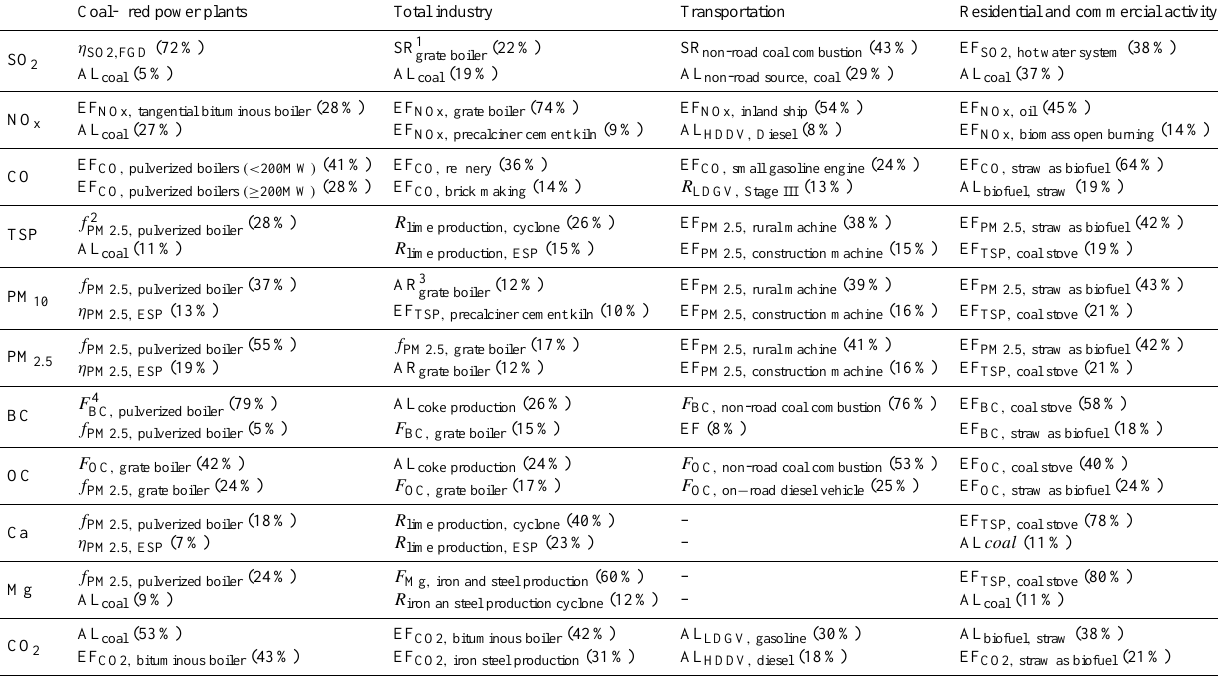
Table 3. The top two parameters contributing most to emission uncertainties by sector for 2010. The percentages in the parentheses indicate the contributions of the parameters to the variances of emissions (see Eq. (1) for the abbreviations of